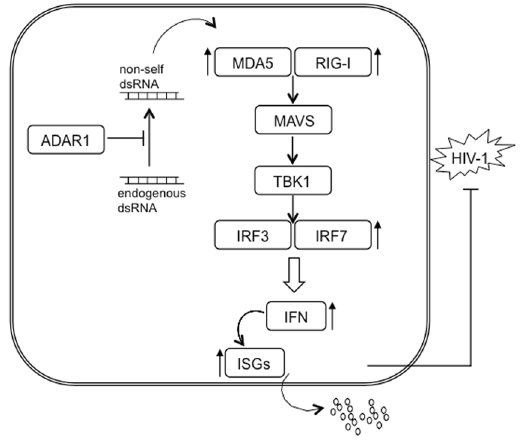
Figure 6. Representation of signaling cascade regulated by ADAR1 in MDM. ADAR1 modulates the recognition of non-self dsRNA in the cytoplasm; consequently, sensing of non-self dsRNA induces expression of RNA sensors, RIG-I and MDA5, through downstream effectors, MAVS and TBK1, and transcription factors IRF3 and IRF7. Leading to induction of an innate immune response characterized by increase expression of type I IFN and ISG and subsequent over production of cytokines and chemokines able to block